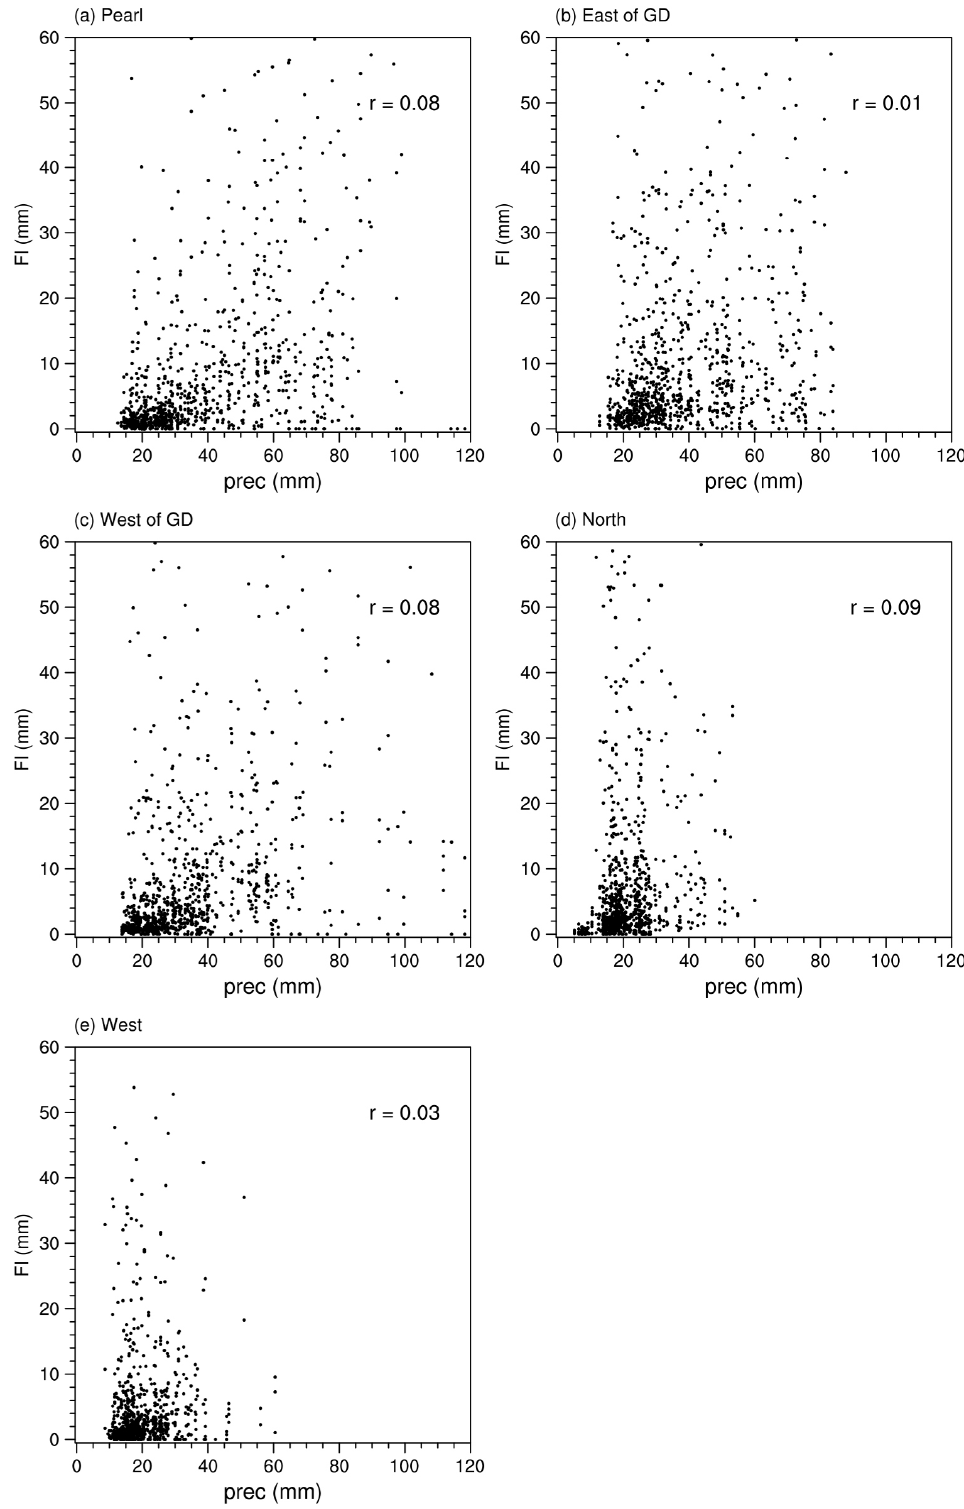
Figure 10. Scatterplots of precipitation and flood intensity for the five classes of typhoon